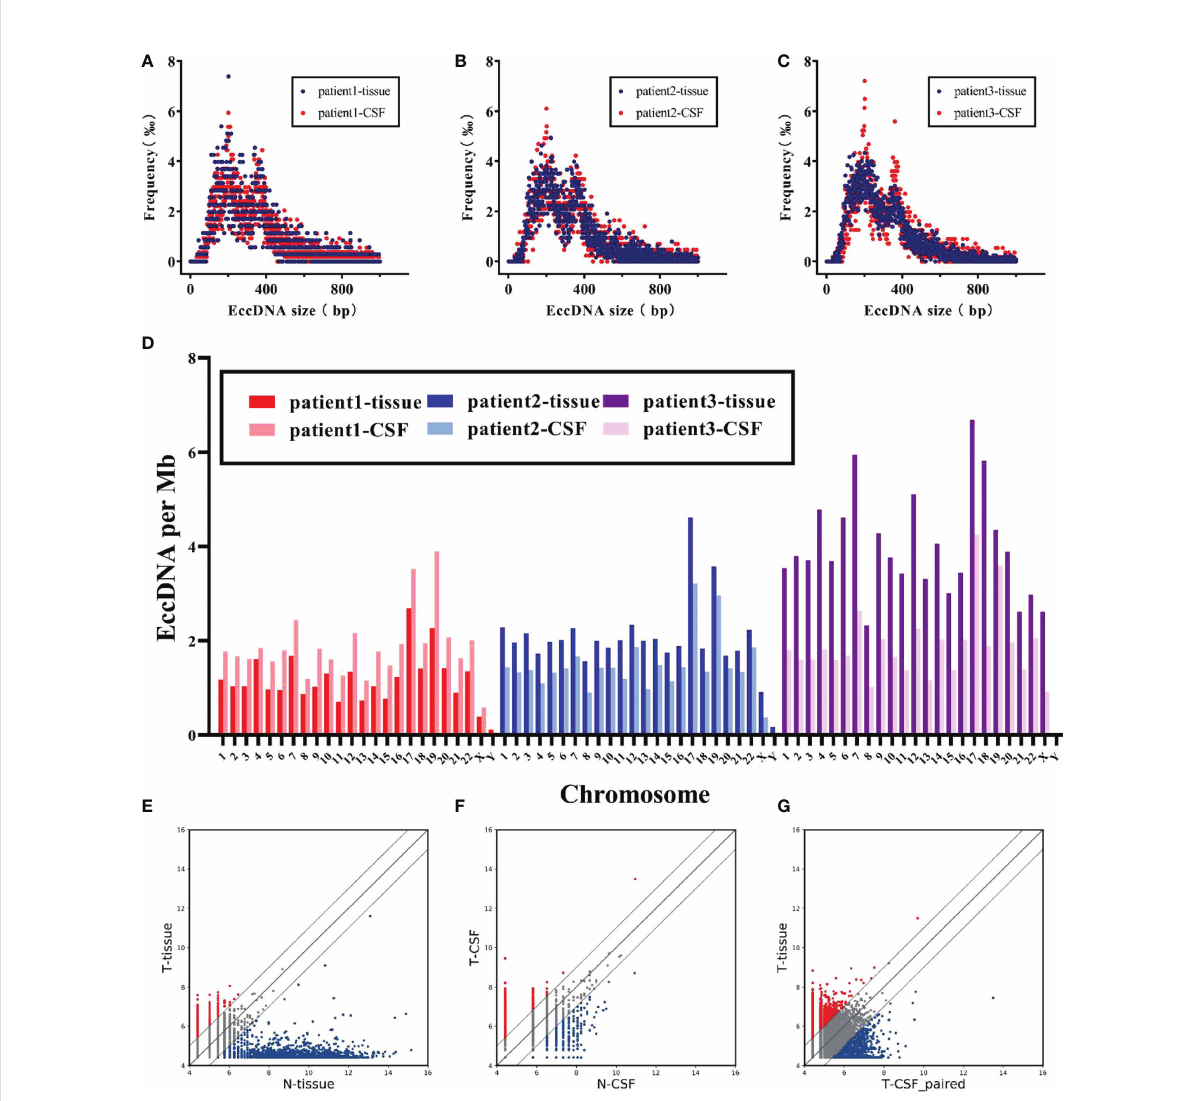
FIGURE 4 Characteristics of eccDNAs were comparable in MB and matched CSF. (A – C) Size distribution of eccDNAs in tissue (red) and CSF (blue) for each patient. (D) Comparison of chromosomal density trend of eccDNAs in tissue and CSF for three patients. (E, F) Scatter plots showing the differential abundance of eccDNAs between MB and normal in tissue and CSF, respectively. (G) Correlation of eccDNAs abundance between MB tumors and matched